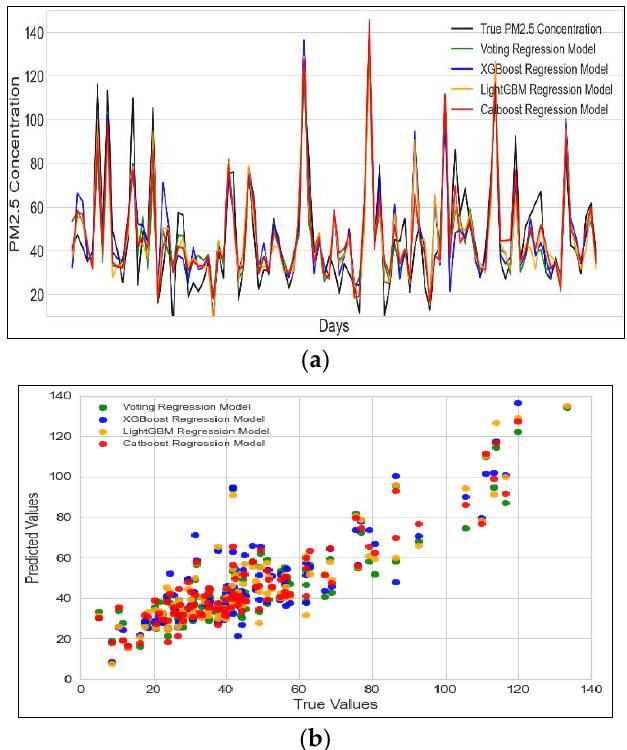
Figure 6. ( a ) Time series plot of true and predicted PM 2.5 concentration for the test dataset using different regression models. ( b ) Scatter plot between true and predicted PM 2.5 concentration on the test dataset using VR, XGB, LGBM and CB models.